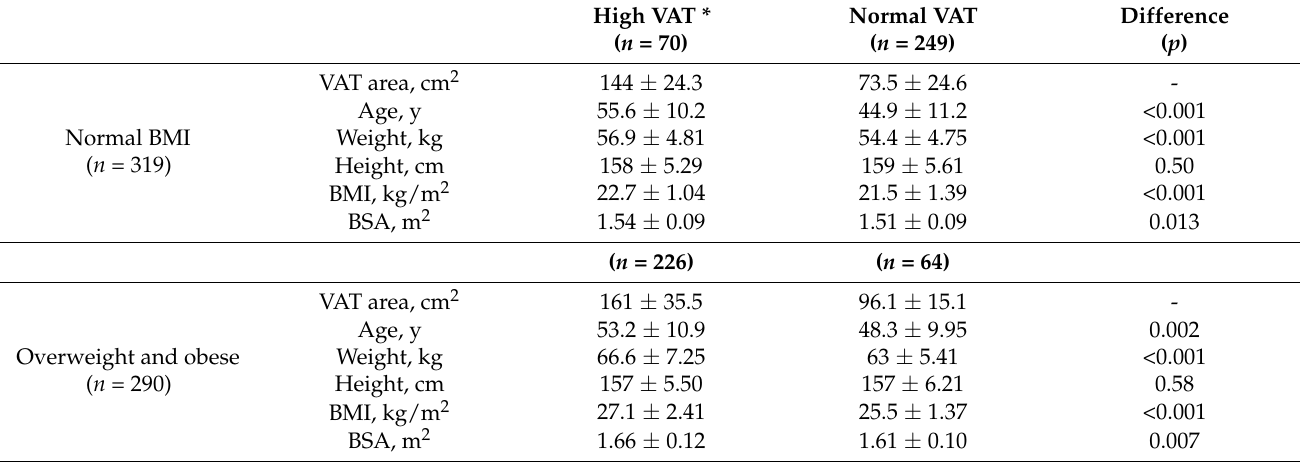
Table 2. Descriptive characteristics of Chinese women ( n = 609) according to BMI and visceral